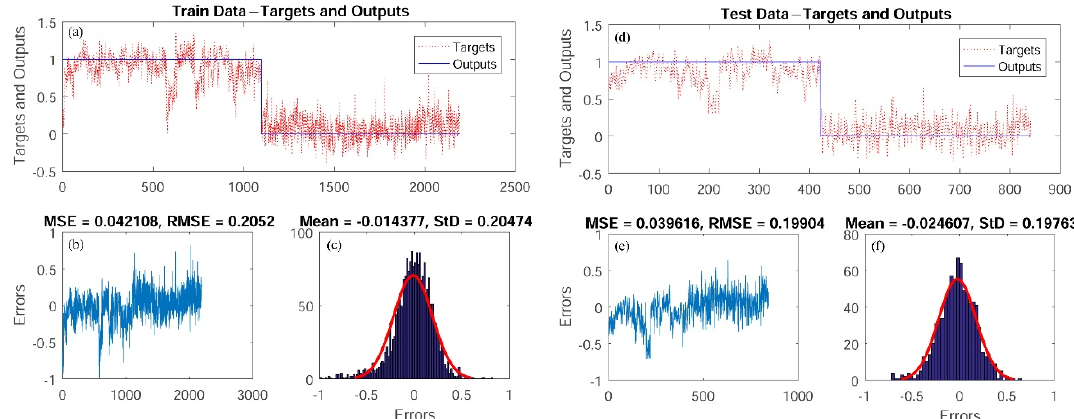
Figure 7. SVR model: ( a ) target and output SVR value of training data samples, ( b ) MSE and RMSE value of training data samples, ( c ) frequency errors of training data samples, ( d ) target and output SVR value of testing data samples, ( e ) MSE and RMSE value of testing data samples, ( f ) frequency errors of testing data samples.